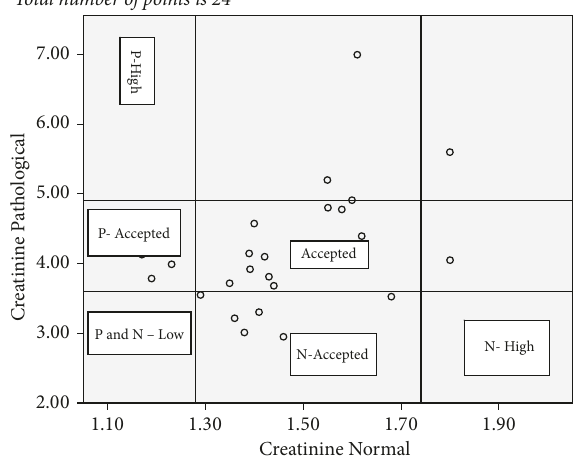
Figure 3: Plot of control sample creatinine pathological P values versus control sample creatinine normal N values for the total of 29 reported points. P: pathological; N: normal.